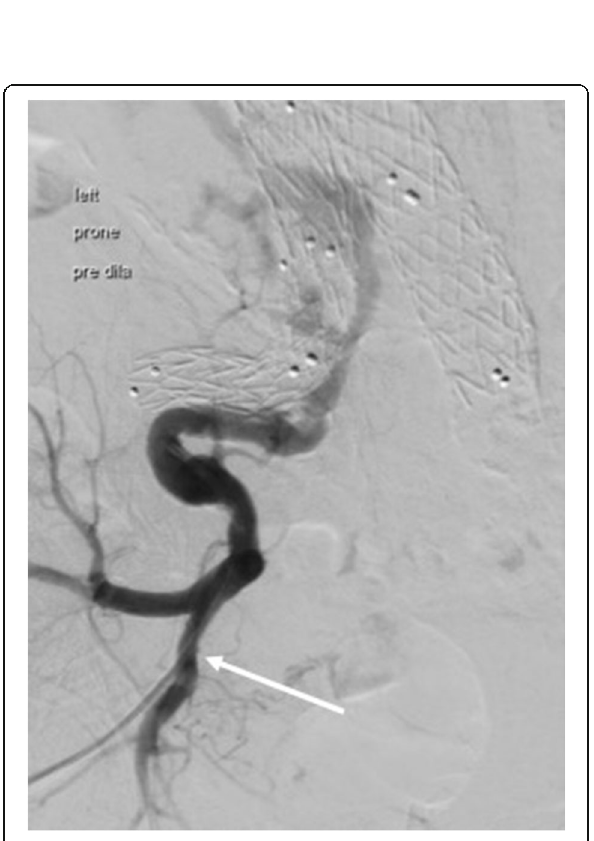
Fig. 3 Angiogram via a 4 Fr catheter inserted in the anterior branch of the left IIA (arrow) demonstrating type II endoleak within the aneurysm sac